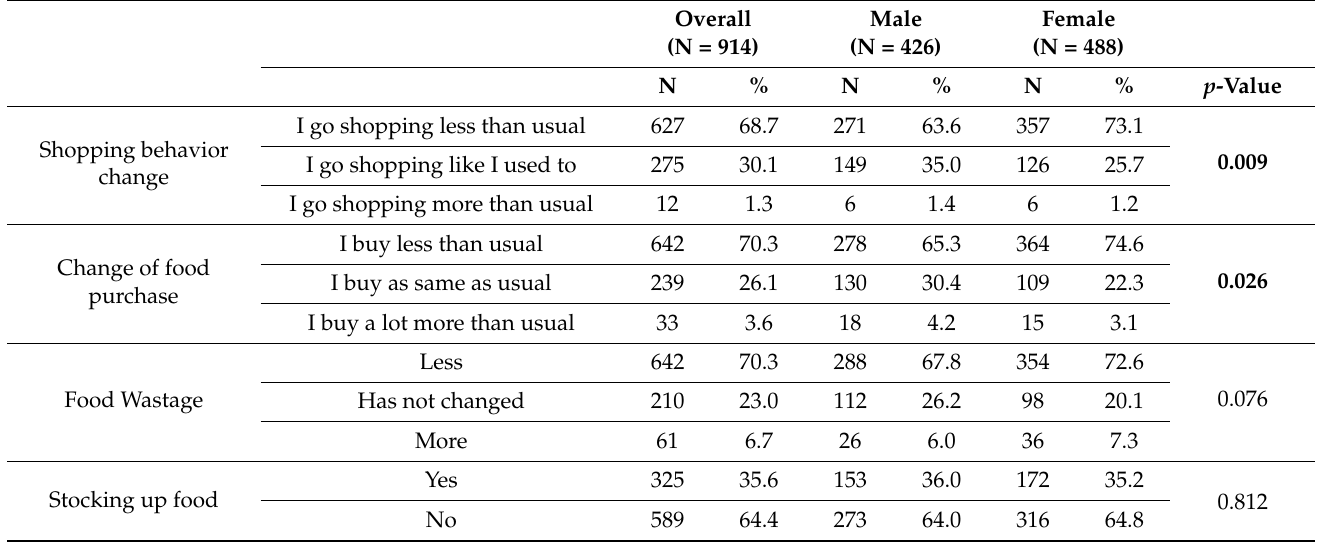
Table 3. Shopping behavior and food wastage changes during the Russia–Ukraine